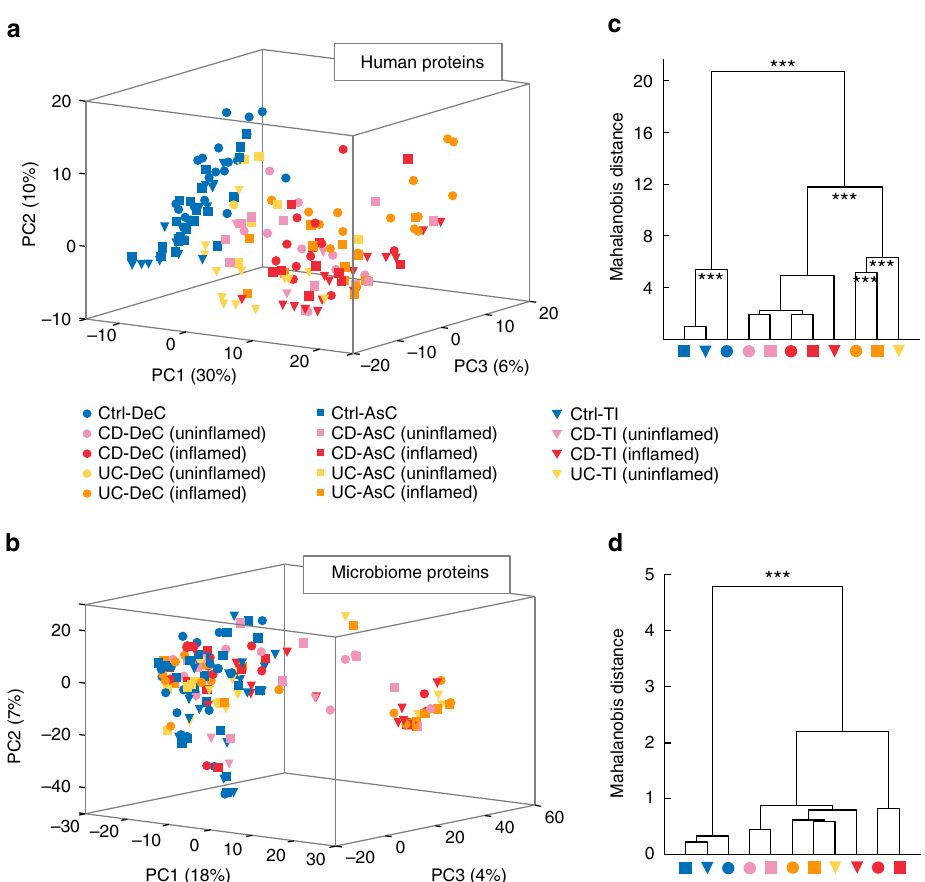
Fig. 2 MLI host and microbiota proteome landscape alterations in pediatric IBD. a PCA score plot of MLI human-derived proteins quanti fi ed in ≥ 50% of the samples; b PCA score plot of MLI microbiome-derived proteins quanti fi ed in ≥ 50% of the samples; c , d Group mean clustering based on Mahalanobis distances calculated with MANOVA test using the fi rst 10 PCs of PCA on MLI human-derives proteins ( c ) and MLI microbiome-derives proteins ( d ). The clusters are computed by applying the single linkage method to the matrix of Mahalanobis distances between group means. *** p <